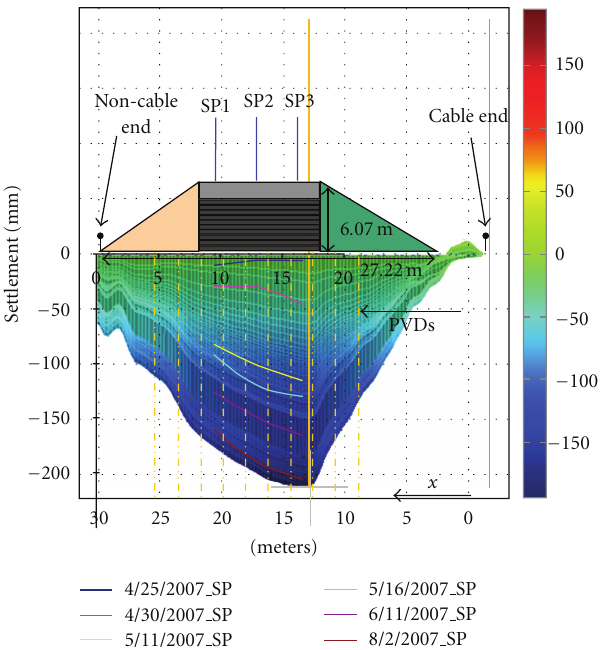
Figure 8: Time history of displacement from three SAA and surface settlement plate locations (consolidation data).